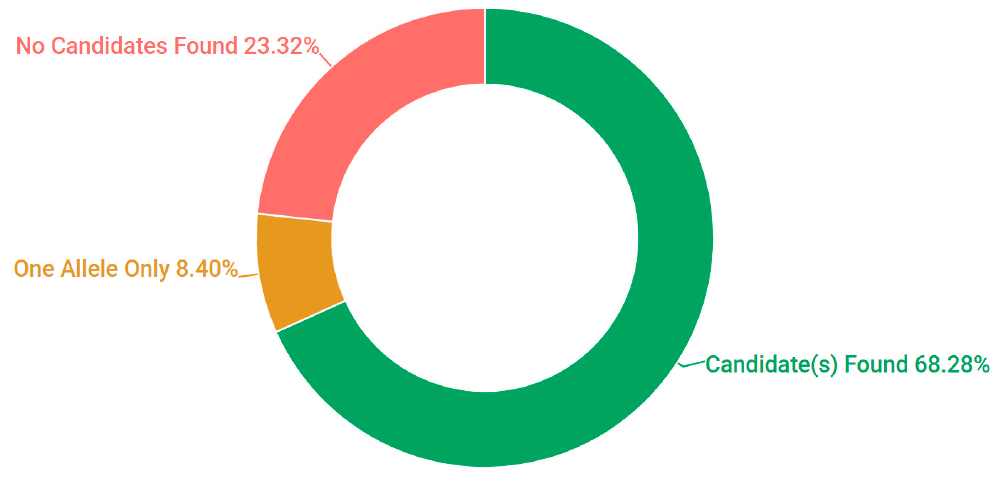
Figure 2. Pedigree solve rates employing target capture next generation sequencing for 254 IRD genes.